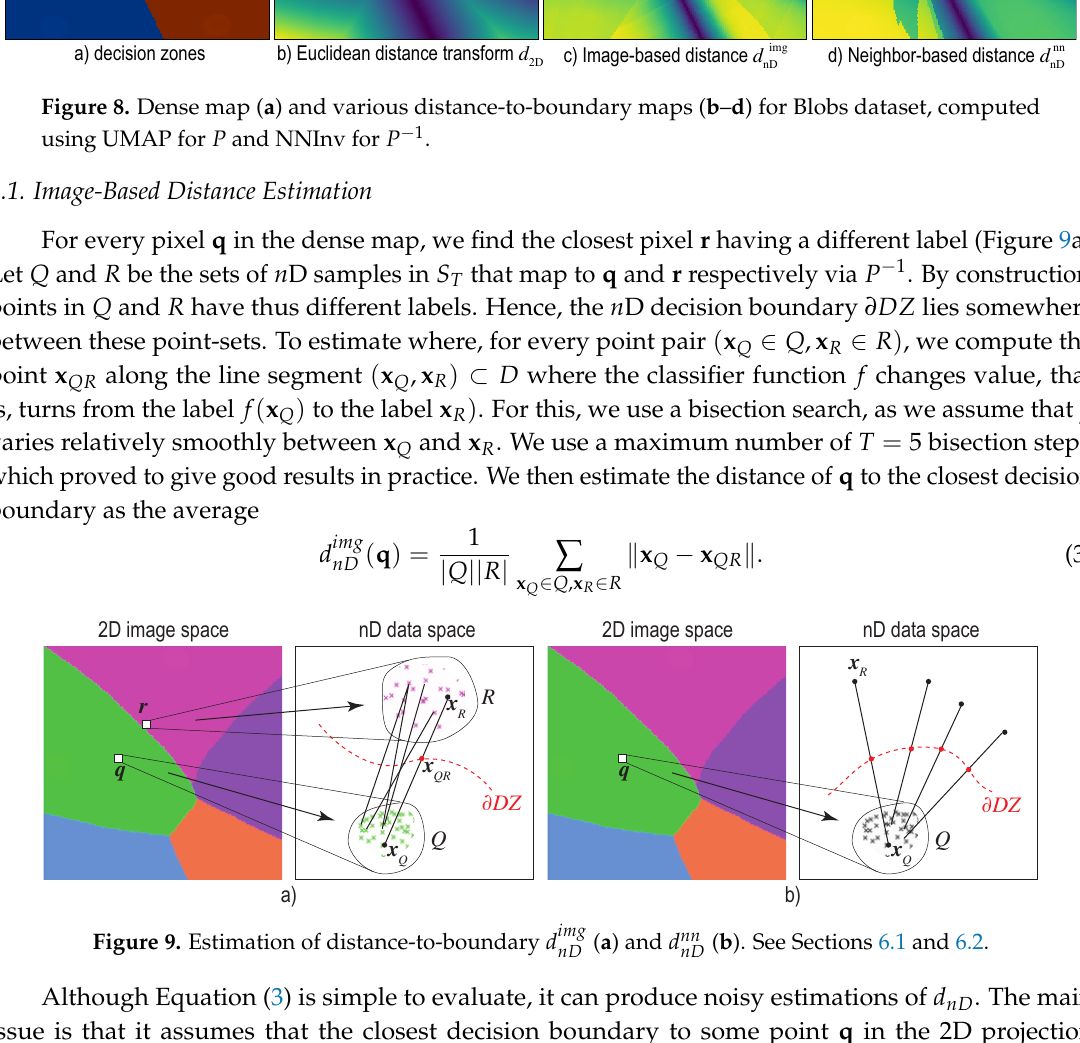
( a ) and d nn ( b ). See Sections 6.1 and nD nD